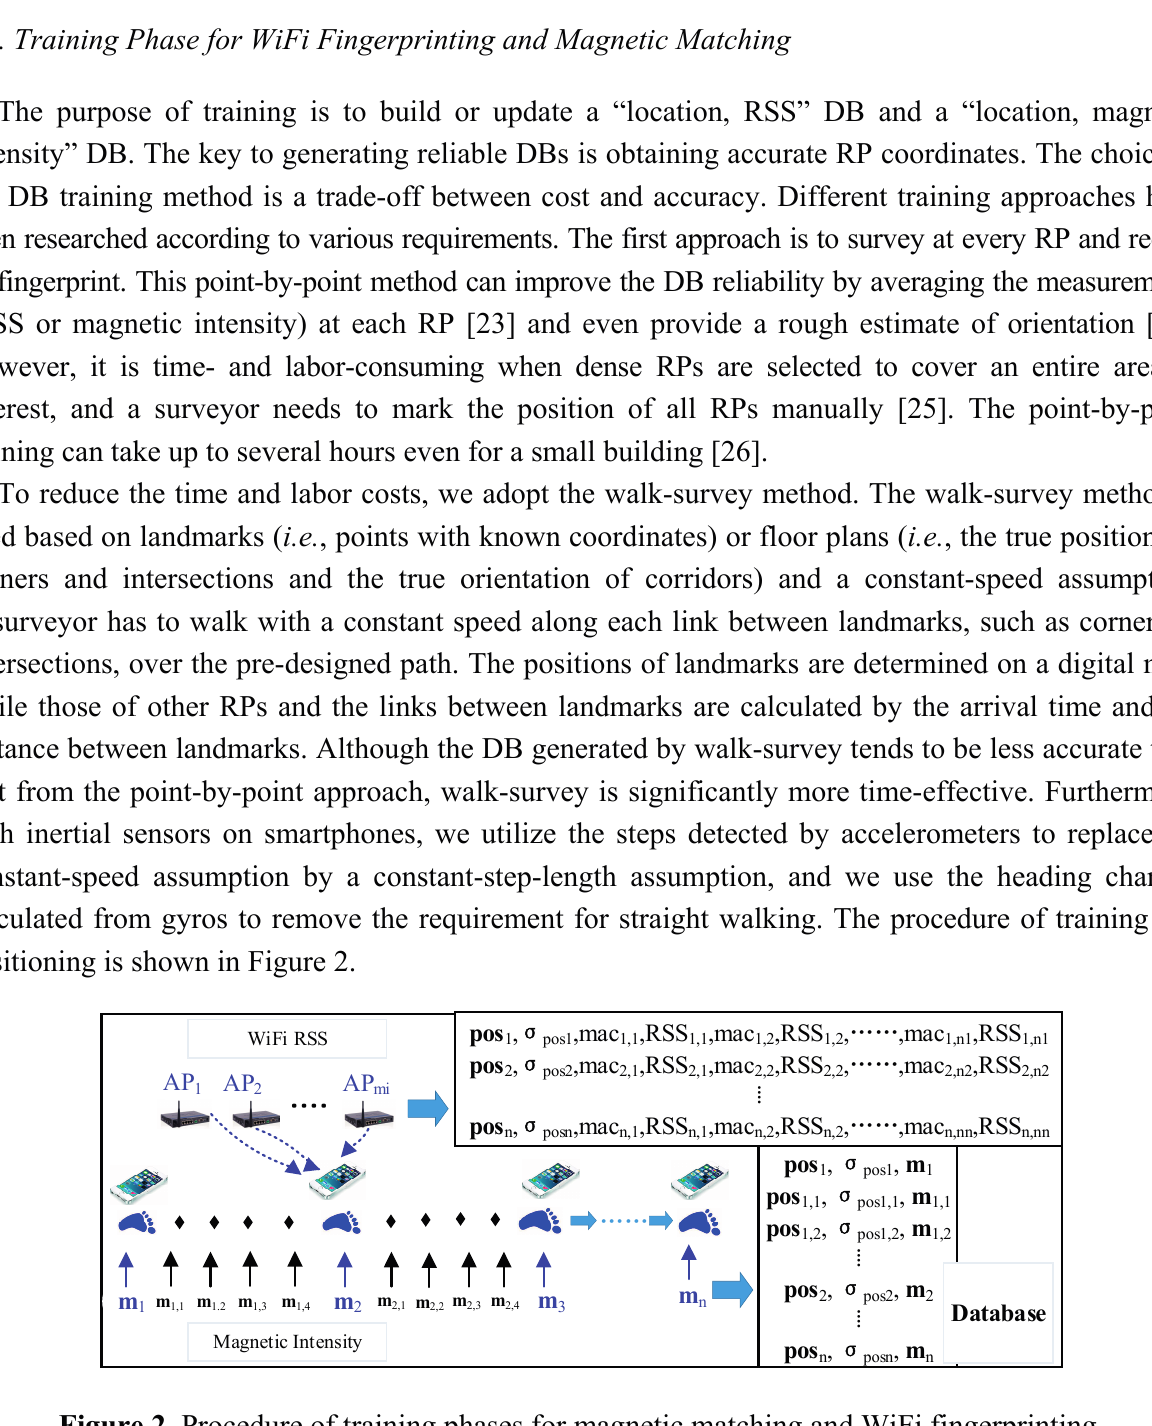
Figure 2. Procedure of training phases for magnetic matching and WiFi